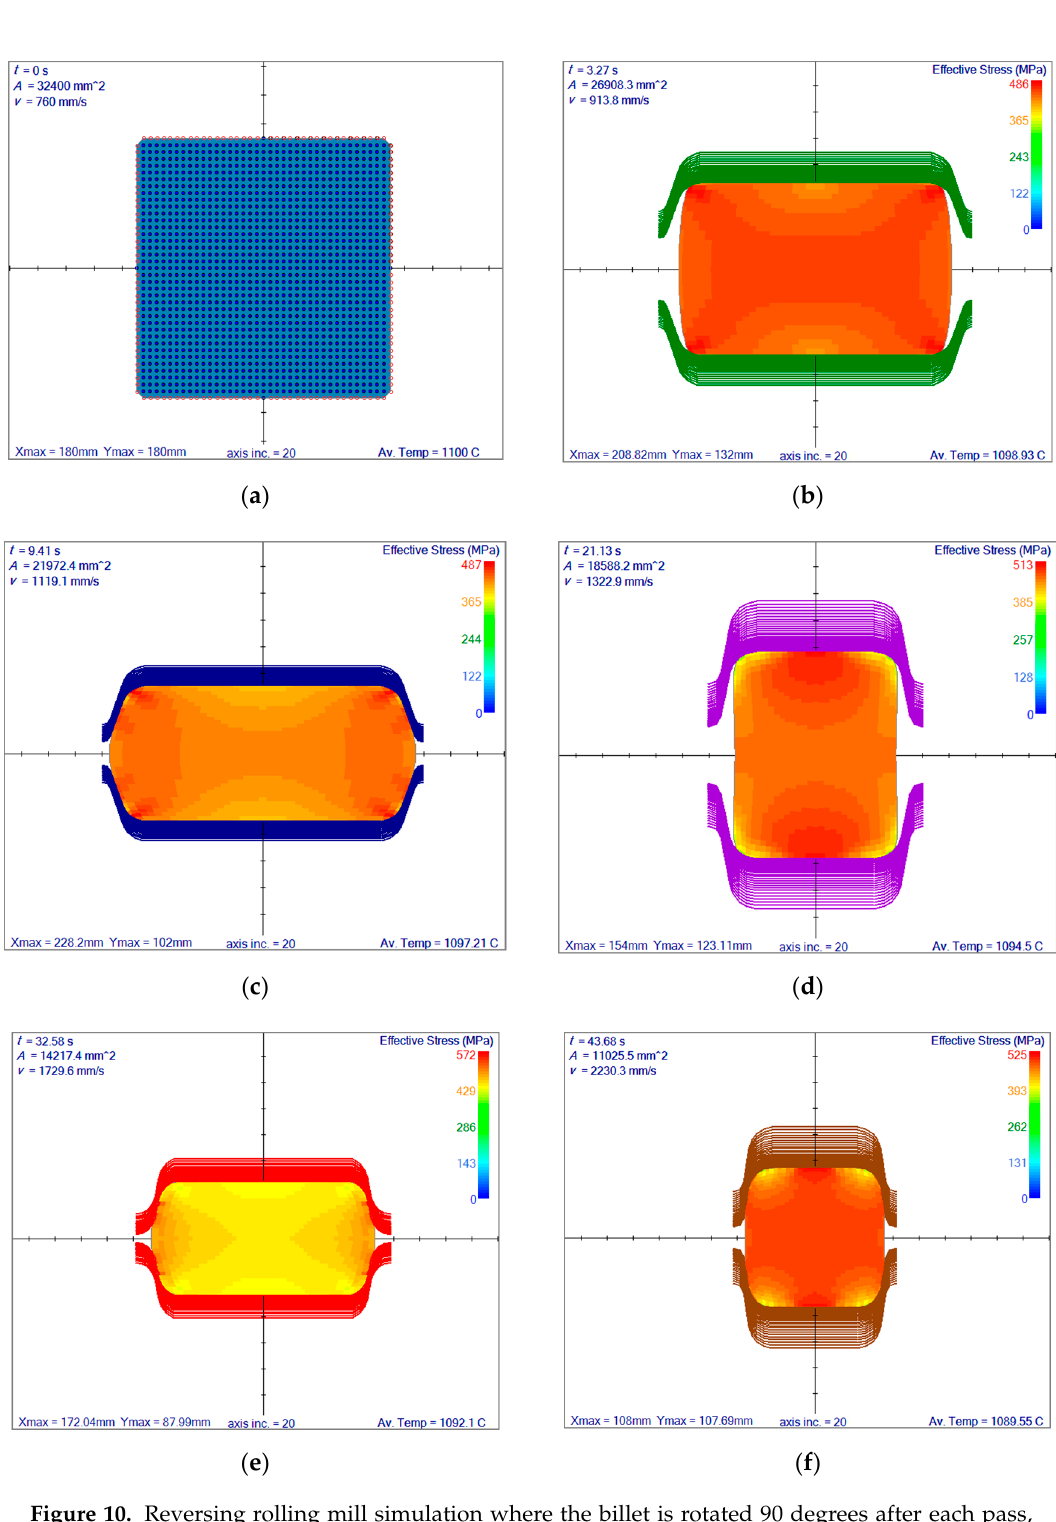
Figure 10. Reversing rolling mill simulation where the billet is rotated 90 degrees after each pass, starting from the second pass and 6 s of rotation time is considered. Results are shown in terms of effective stress field. ( a ) Initial size, ( b ) after first pass, ( c ) after second pass, ( d ) after third pass, ( e ) after fourth pass, ( f ) after fifth pass.